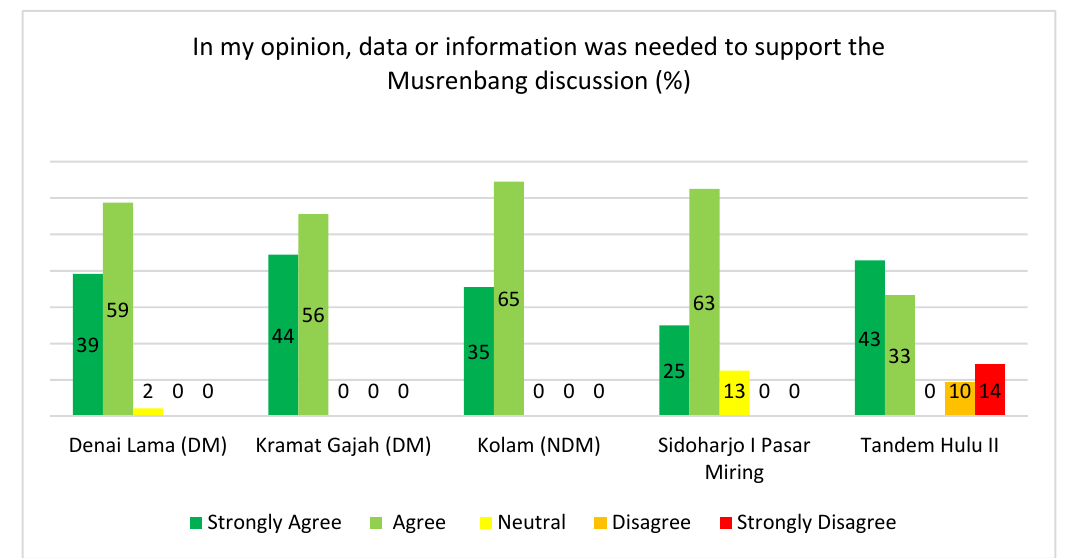
Figure 6. The importance of having data to support the Musrenbang.